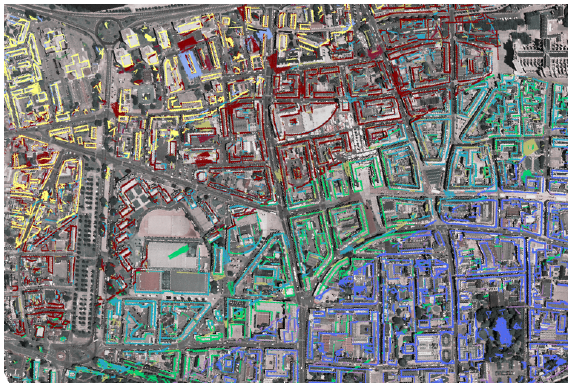
Figure 7: Extracted feature before vegetation filtering : one colour per